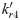
WEE1-mediated regulation of preMPF and MPF oscillations.(A) Approximated steady-state protein levels from studies by Ovejero et al. [8] using immunoblot analysis for CDK1T, CCNB1T, WEE1T and CDK1P Y15 (i.e. preMPF) in WEE1-expressing U2OS cells following release from synchronization in M phase. Arrows mark points of comparison between in vitro and in silico data. (P, phosphorylated protein; T, total protein) (B) Levels of WEE1P (S139) observed in immunoprecipitated WEE1T from studies by Ovejero et al. [8] as described in (A). (C) Approximated changes in protein levels for WEE1T and mutated unphosphorylated WEE1T 2A (S139A, S123A) during cycloheximide treatment by Ovejero et al. [8]. (D) Simulation of phosphatase activity (PPase, kr4′) in regulating free WEE1, WEE1P and WEE1T with associated oscillations in CDK1T, CCNBT, preMPF (CCNB1:CDK1P), and active MPF kinase (CCNB1:CDK1) over the indicated time periods. Boxed area is magnified. (E) Disrupting relationships by siRNA-mediated reduction of phosphatase CDC14A (+) in asynchronized U2OS cells and associated changes in levels of WEE1T and CDK1P Y15 (i.e. preMPF) compared to control by Ovejero et al. [8]. (F) Approximated changes in WEE1, WEE1T and WEE1P levels upon increasing expression of CDC14A phosphatase as demonstrated by Ovejero et al. [8]. (G) Simulated decrease in phosphatase (PPase, i.e. CDC14A) activity (kr4′) and associated changes in protein concentrations and mitotic oscillations of CDK1T, CCNBT, WEE1, WEE1T, WEE1P, preMPF (CCNB1:CDK1P), and active MPF kinase (CCNB1:CDK1). In contrast, simulated increase in PPase activity (kr4′) and associated changes resulting in a mitotic collapse with no active MPF kinase (CCNB1:CDK1) over 96 hr.